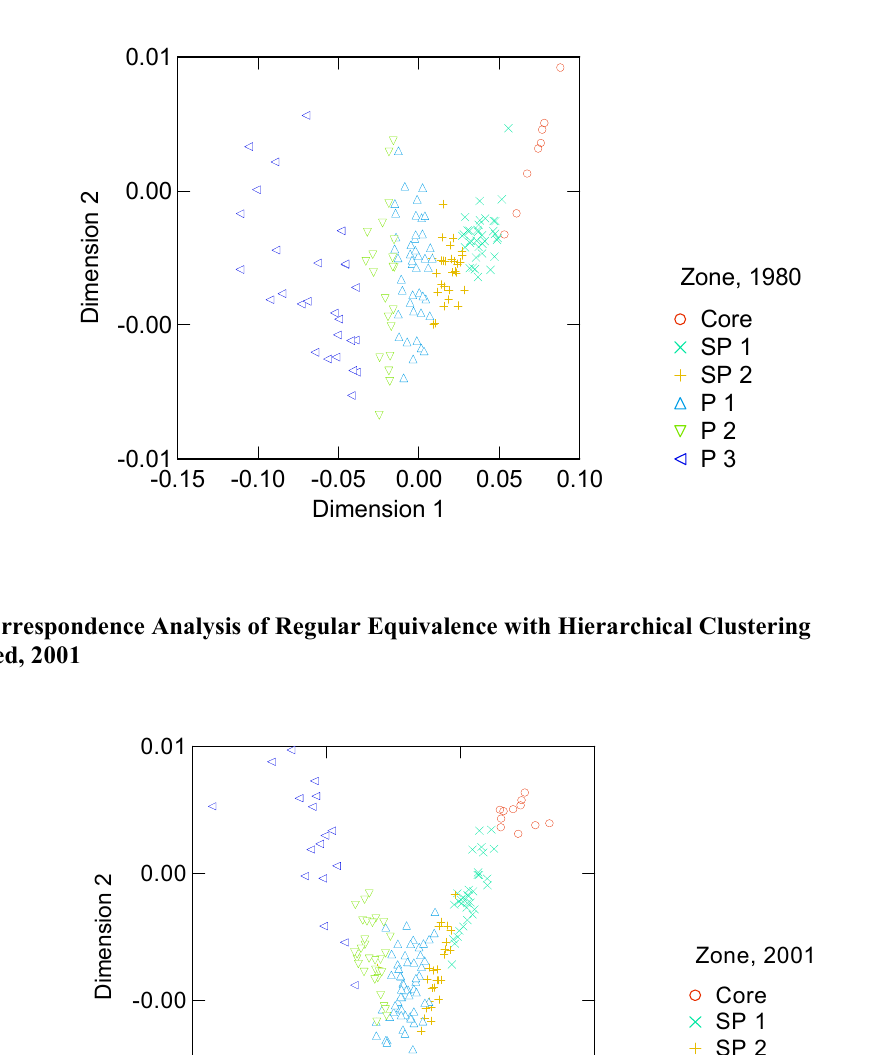
Figure 2: Correspondence Analysis of Regular Equivalence with Hierarchical Clustering Superimposed, 1980